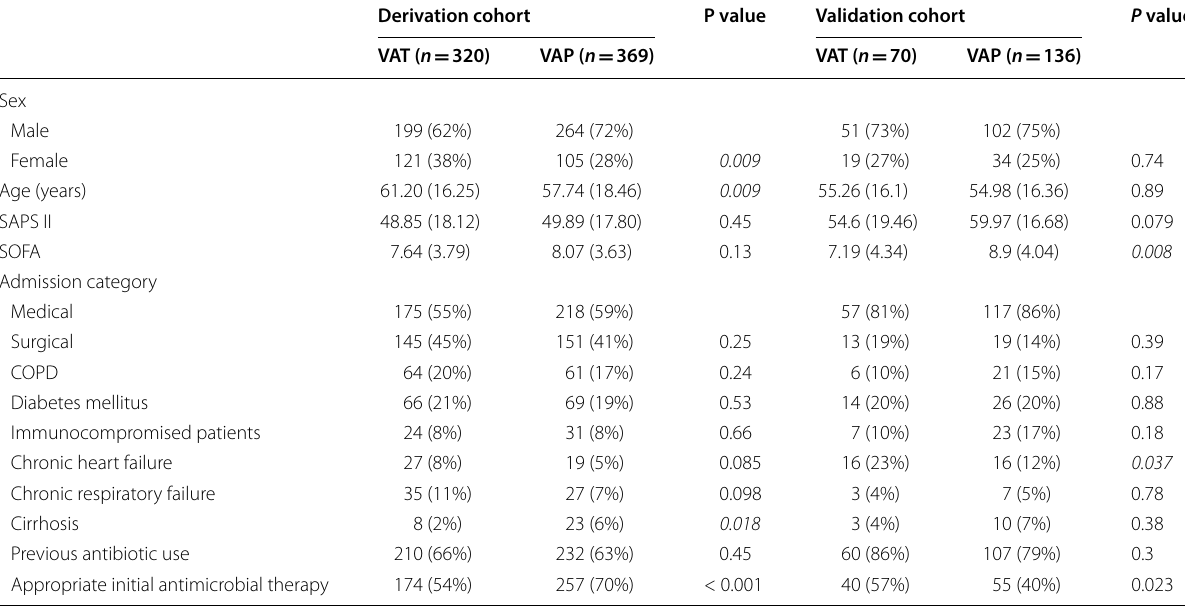
Data are presented as number (%) or mean (SD) COPD Chronic obstructive pulmonary disease, SAPS Simplified acute physiology score, SOFA Sequential organ failure assessment, VAP Ventilator-associated pneumonia, VAT Ventilator-associated tracheobronchitis p value < 0.05 is indicated in italic